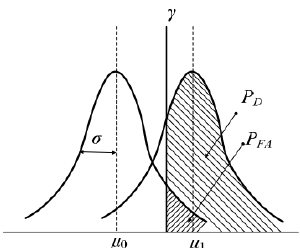
Figure 2. Normal distribution of detection probability of sonar.